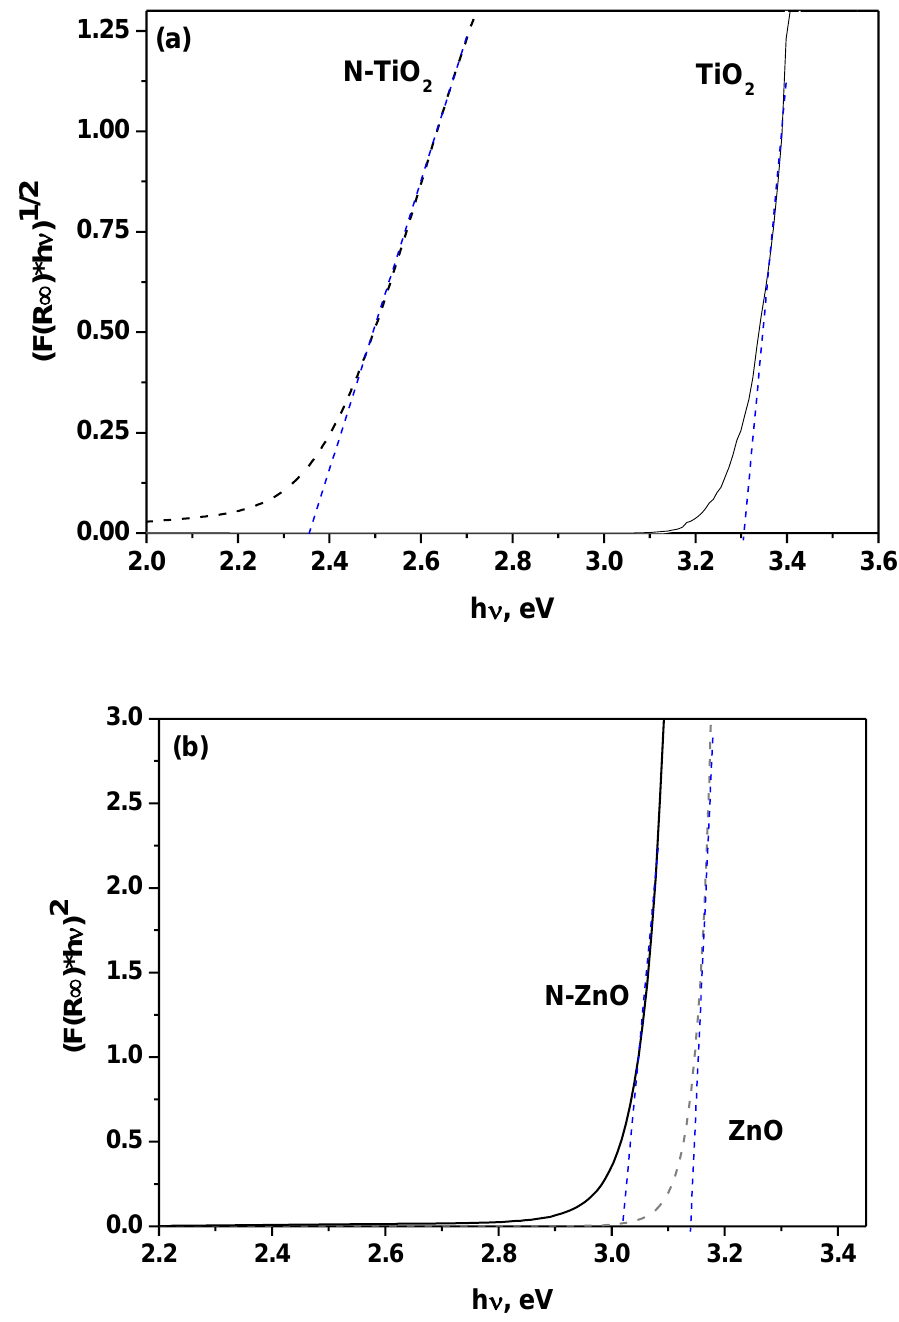
Figure 2. Band-gap estimation for ( a ) TiO 2 and N-TiO 2 , as well as ( b ) ZnO and N-ZnO samples. Raman spectroscopic analysis was employed to examine the possible variations in Raman active vibrational modes of TiO 2 and ZnO due to the presence N into the host lattice (Figure 3). For both TiO 2 and N-TiO 2 samples (Figure 3a), all the signals can be assigned to the Raman active modes of the anatase crystal phase [25,26]. Moreover, a slight blue shift of the Raman active mode (E g(1) ) was observed from 144 to 146 cm − 1 for the doped sample, clearly indicating the presence of a nonstoichiometric TiO 2 − x phase [27,28]. For both ZnO and N-ZnO spectra (Figure 3b), a prominent peak was detected at 438 cm − 1 , which was as- sociated with the Raman-active dominant mode (E 2 (H)) of wurtzite ZnO [29]. Furthermore, two less intense Raman bands were observed at 330 and 378 cm − 1 and assigned to E 2 (H)– E 2 (L) (multi-phonon) and A 1 (TO) modes of wurtzite ZnO, respectively [30]. The